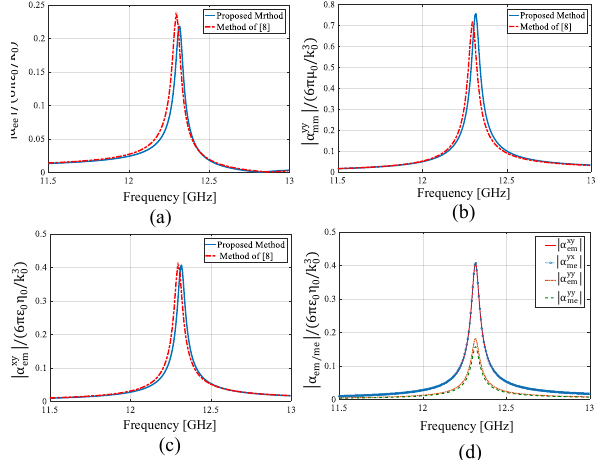
Figure 2: Particles schematics and dimensions and their associated local coordinate system. (a) Omega particle, (b) magneto-dielectric particle, and (c) an electric resonance particle.